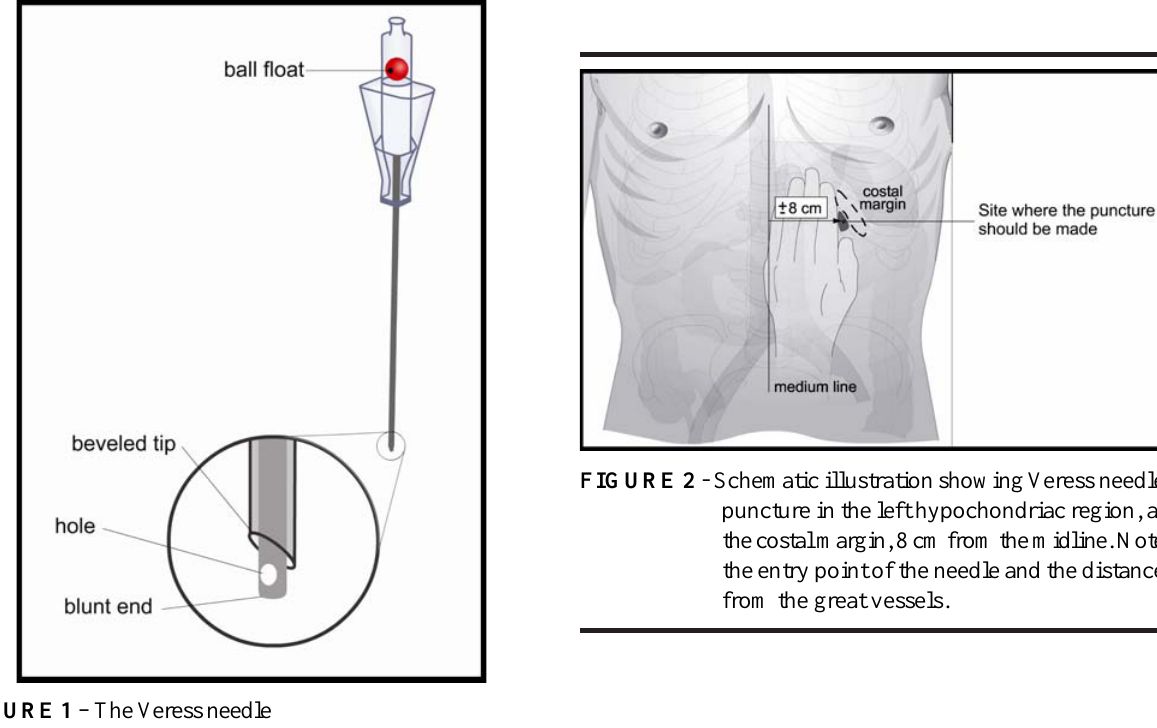
FIGURE 1 – The Veress needle